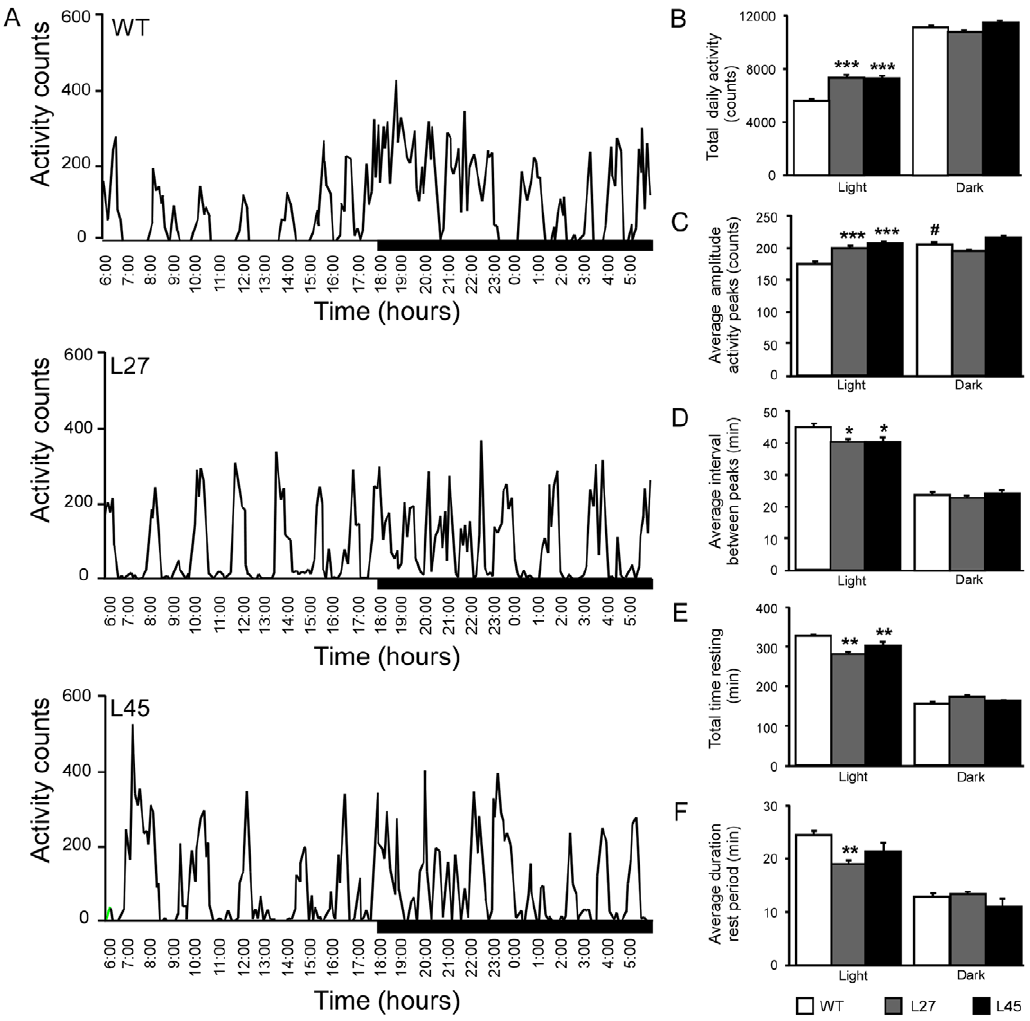
Figure 1. GFAP-DNSynCAM1 mice have increased locomotor activity and shortened resting intervals during a 24 h period. Adult male GFAP-DNSynCAM1 L27 (n=8), L45 (n=6) mice and WT littermates (n=8) were housed individually and 24-hour activity was recorded in 6- minute bins for a period of one week using MiniMitter telemetry devices. ( A ) Representative 24-hour activity profiles from one WT littermate (upper panel) and two GFAP-DNSynCAM1 adult male mice (Line 27, middle panel; L45, lower panel). ( B ) Average cumulative daily activity counts for both light and dark periods. ( C ) Average amplitude of activity spikes during light and dark periods (number of activity counts per 6-minute bin). ( D ) Average frequency of activity peaks (minutes) for light and dark periods. ( E ) Average cumulative time spent resting (minutes) during light and dark periods (6-minute bins recorded as zero movement). ( F ) Average duration of each rest period (minutes) for both light and dark periods. Activity was analyzed in the light and dark periods for WT (white bars), DN-SynCAM1 L27 (grey bars) and DN-SynCAM1 L45 (black bars). For all graphs data are expressed as the mean 6 SEM. Data are analyzed using a two way ANOVA (period by genotype) followed by Student-Newman-Keuls post hoc analysis, * p , 0.05; ** p , 0.01; *** p ,